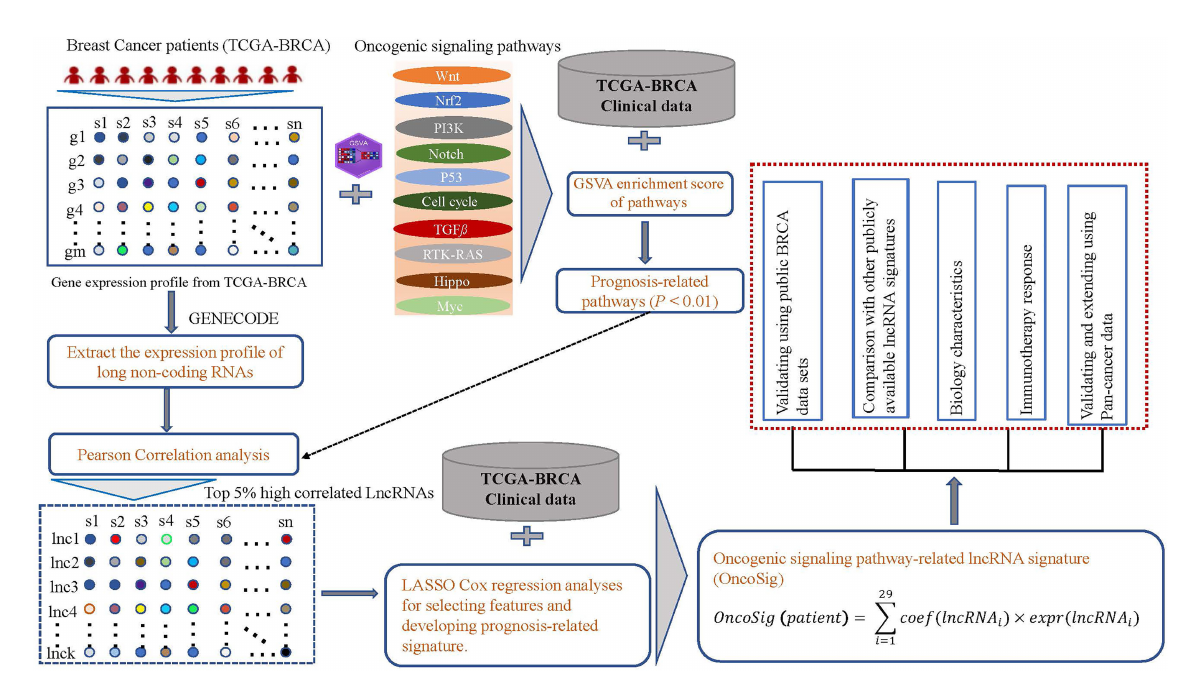
FIGURE 1 Analysis overview. Transcriptomic, mutational, and clinical data for breast cancer (BC) patients were collected from The Cancer Genome Atlas (TCGA) database. The GSVA tool was used to assess the enrichment scores (ESs) of 10 oncogenic signaling pathways in each patient. Long non- coding RNAs (lncRNAs) were extracted based on the annotation information in GENECODE, and the correlation coef fi cients between the lncRNA levels and ESs of each prognostically relevant pathway were calculated. Only the top 5% of relevant lncRNAs were retained for each oncogenic signaling pathway and further combined with clinical data to screen for lncRNAs signi fi cantly associated with prognosis, resulting in the retention of 29 lncRNAs. The weighting coef fi cients for these lncRNAs were estimated using multivariate Cox regression to generate the OncoSig signature. Lastly, BC and pan-cancer cohorts were used to assess the potential biological characteristics of the signatures as well as their broader clinical